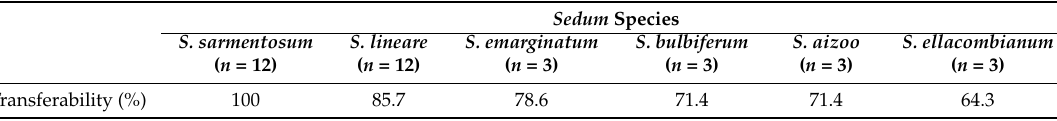
Table 3. Transferability of 14 microsatellite markers for the Sedum